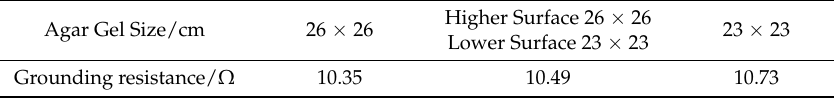
Table 3. The changes in grounding resistance with different agar